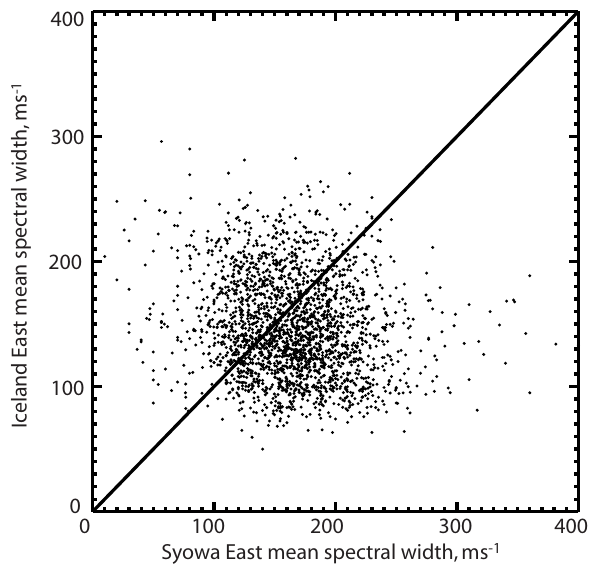
Fig. 7. Scatter plot of simultaneous and co-located mean spectral widths from the statistics databases of the Syowa East and Iceland East radars. The diagonal line represents a one-to-one relationship for